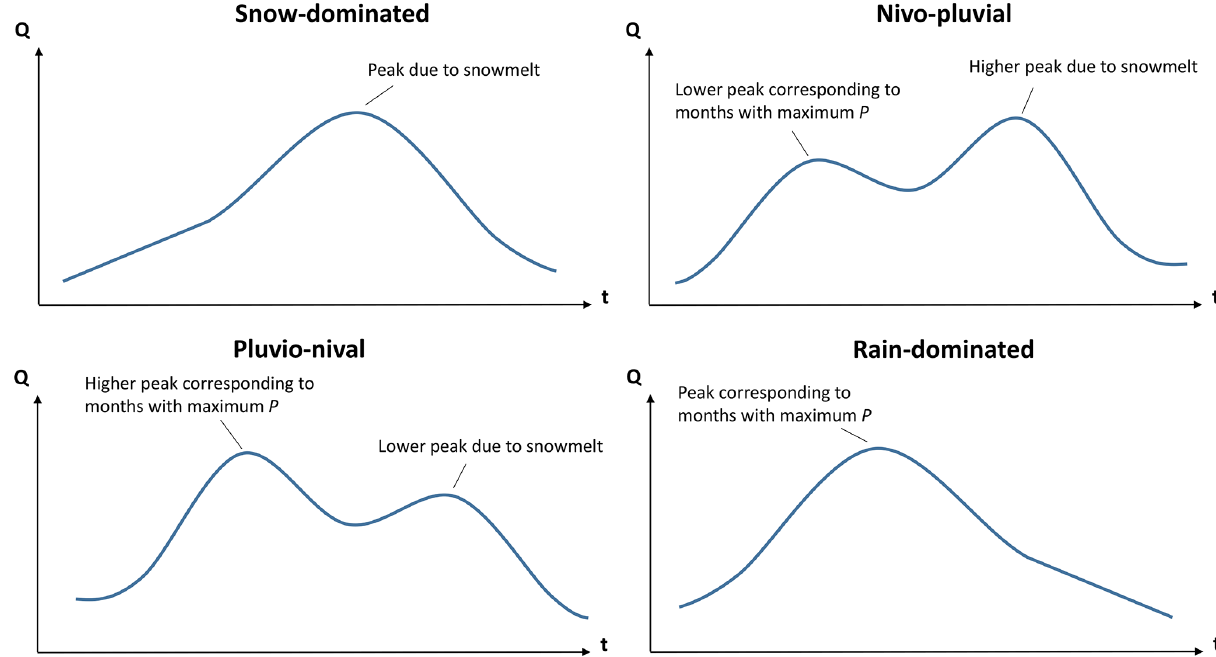
Figure A1. Conceptual illustration of the hydrological regimes used to classify the 100 near-natural catchments used in this